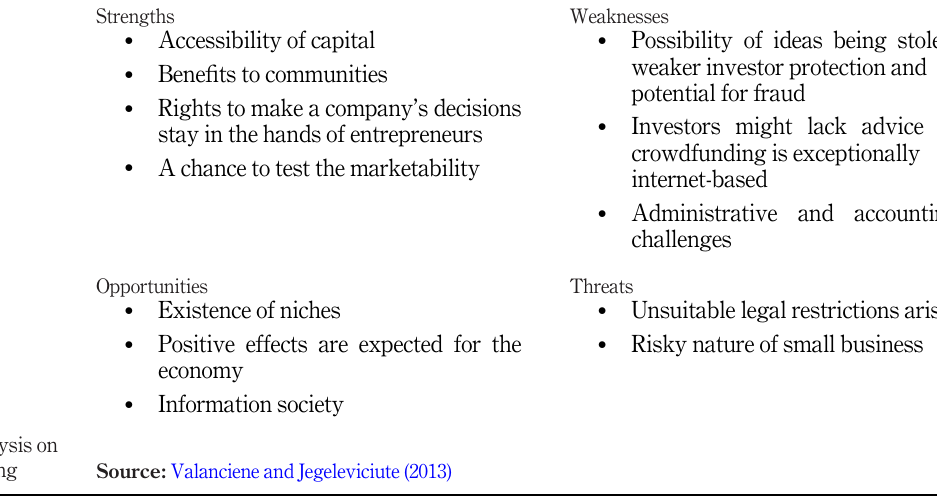
Table I. SWOT analysis on